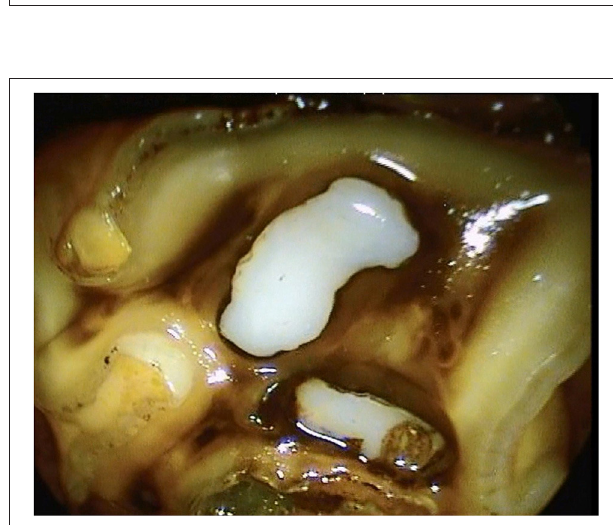
FIGURE 11 | Oroscopic image of a Triadan 209 tooth 10 years post-restoration of the mesial infundibulum.